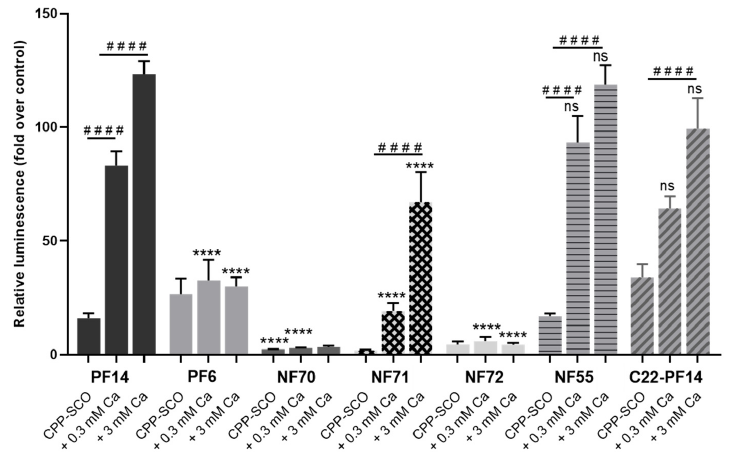
Figure 6. Effect of calcium ions on biological efficiency of nanoparticles formed with different cell- penetrating peptides. HeLa pLuc 705 cells were incubated with nanoparticles of 100 nM SCO-705, 500 nM CPP and 0.3 or 3 mM Ca 2+ for 24 h, and luciferase activity was measured. Each dataset represents mean + SEM of at least 3 independent experiments. Data was analyzed by one-way ANOVA with Dunnett’s test. Asterisks indicate statistically significant difference compared to corresponding nanoparticle with PF14 (i.e., with one of first three columns), **** p -value < 0.0001, ns—not significant. Hashes indicate statistically significant difference within one group, #### p -value < 0.0001.